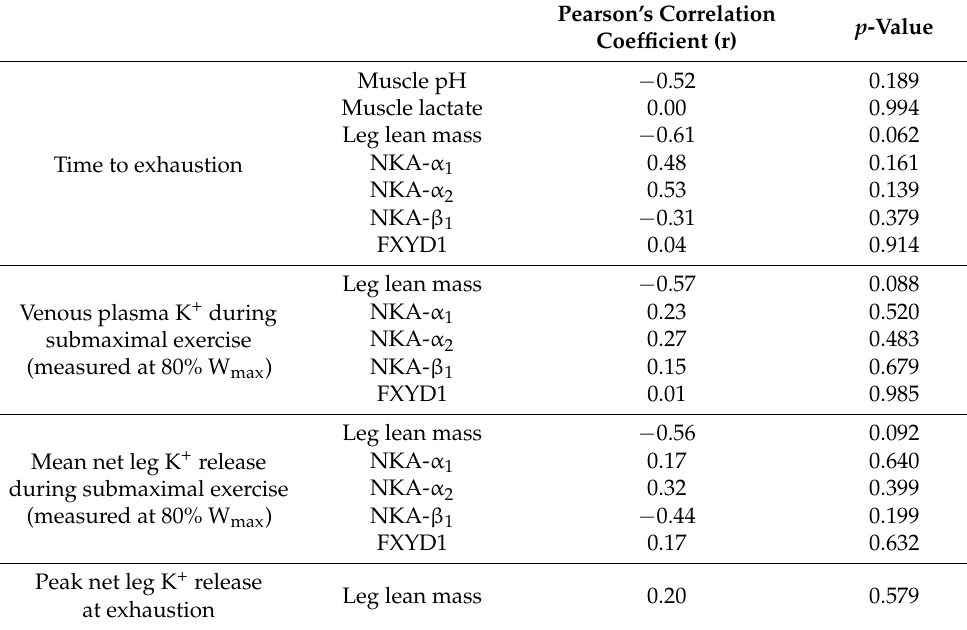
Table 4. Correlation for change percentages in SET saline for main